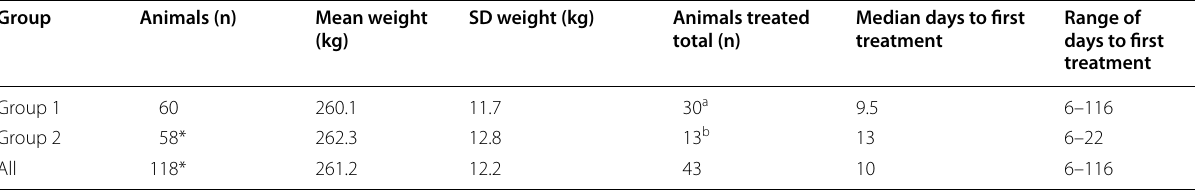
Values in the same column width different superscripts indicate significant difference (Chi-square; ab, P *Unique animal IDs were mis-recorded for two cattle preventing the ability to link feedlot records regarding weight and BRD occurrence